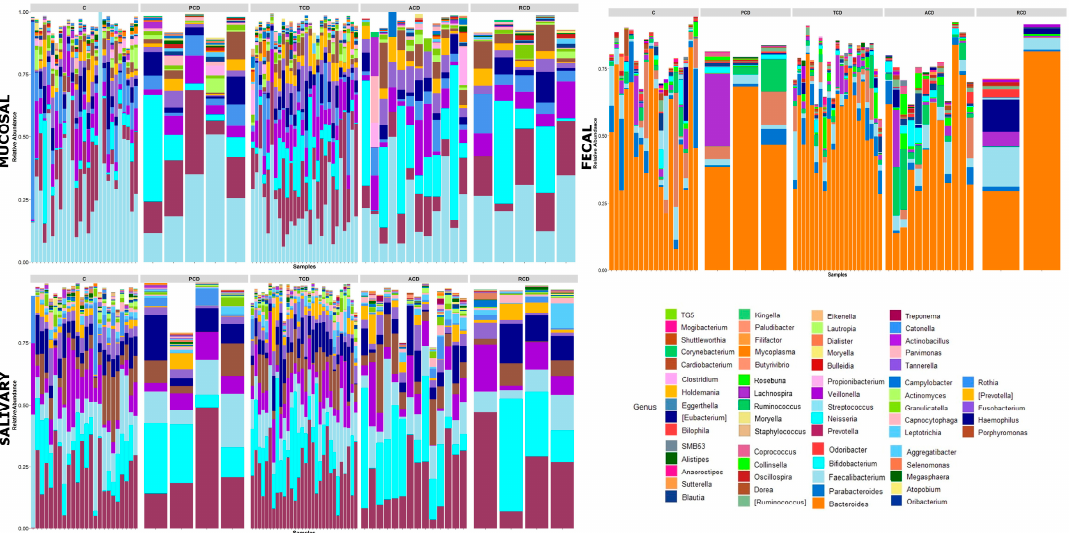
Figure 2. Genus-level classification of bacteria identified in individual mucosal, salivary, and fecal samples belonging to the five study groups: Each bar represents the relative contribution of genus-level profiles with an abundance of at least 1% in each considered sample as indicated on the top of each panel. Sixty-nine different genera were identified across the three biotypes and are represented by different colors as indicated in the legend. An expansion of Neisseria and a reduction of Streptococcus in celiac groups with respect to controls emerge in both mucosal and salivary communities, whereas Bacteroides is the predominant one in the stool consortium.